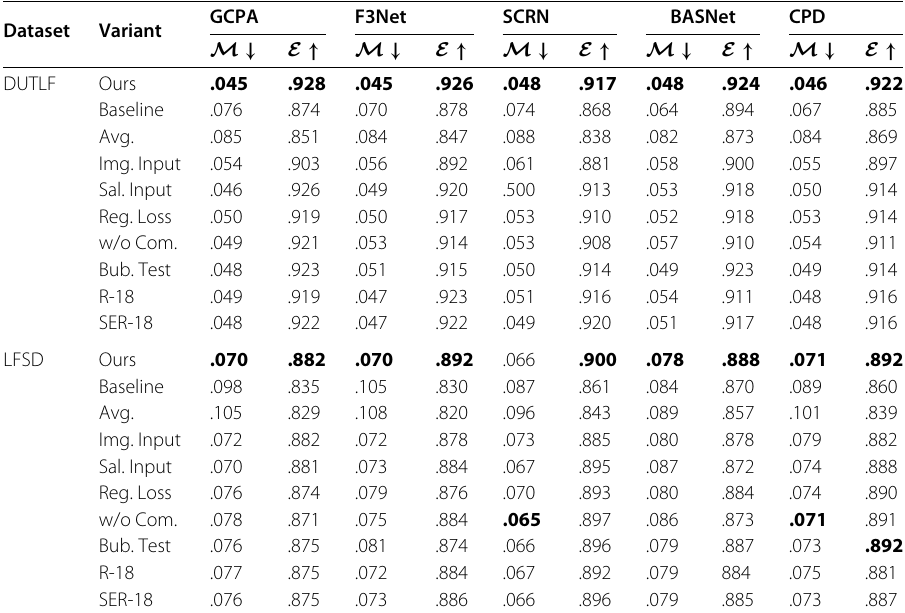
Table 2 Ablation study of the proposed method. Baseline denotes the results of 2D methods over all-focus images while Avg. denotes the average results of 2D methods over all slices. Img. Input and Sal. Input denote the model trained only with RGB images and saliency maps, respectively. Reg. Loss and w/o Com. denote learning the model with the regression loss and without the proposed comparator, respectively. Bub. Test denotes testing the trained model as a bubble sorting